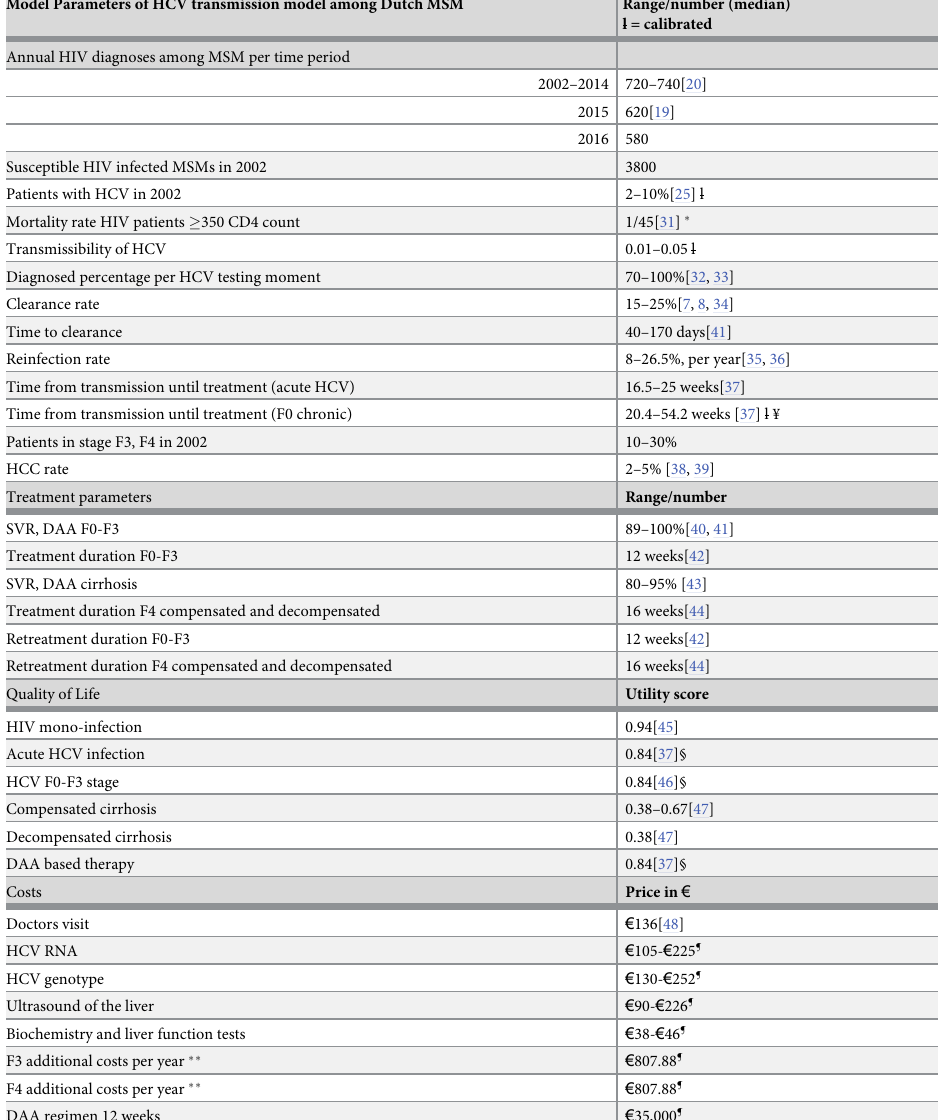
Table 1. Model parameters and ranges used in hepatitis C (HCV) transmission model. ModelParametersofHCVtransmissionmodelamong